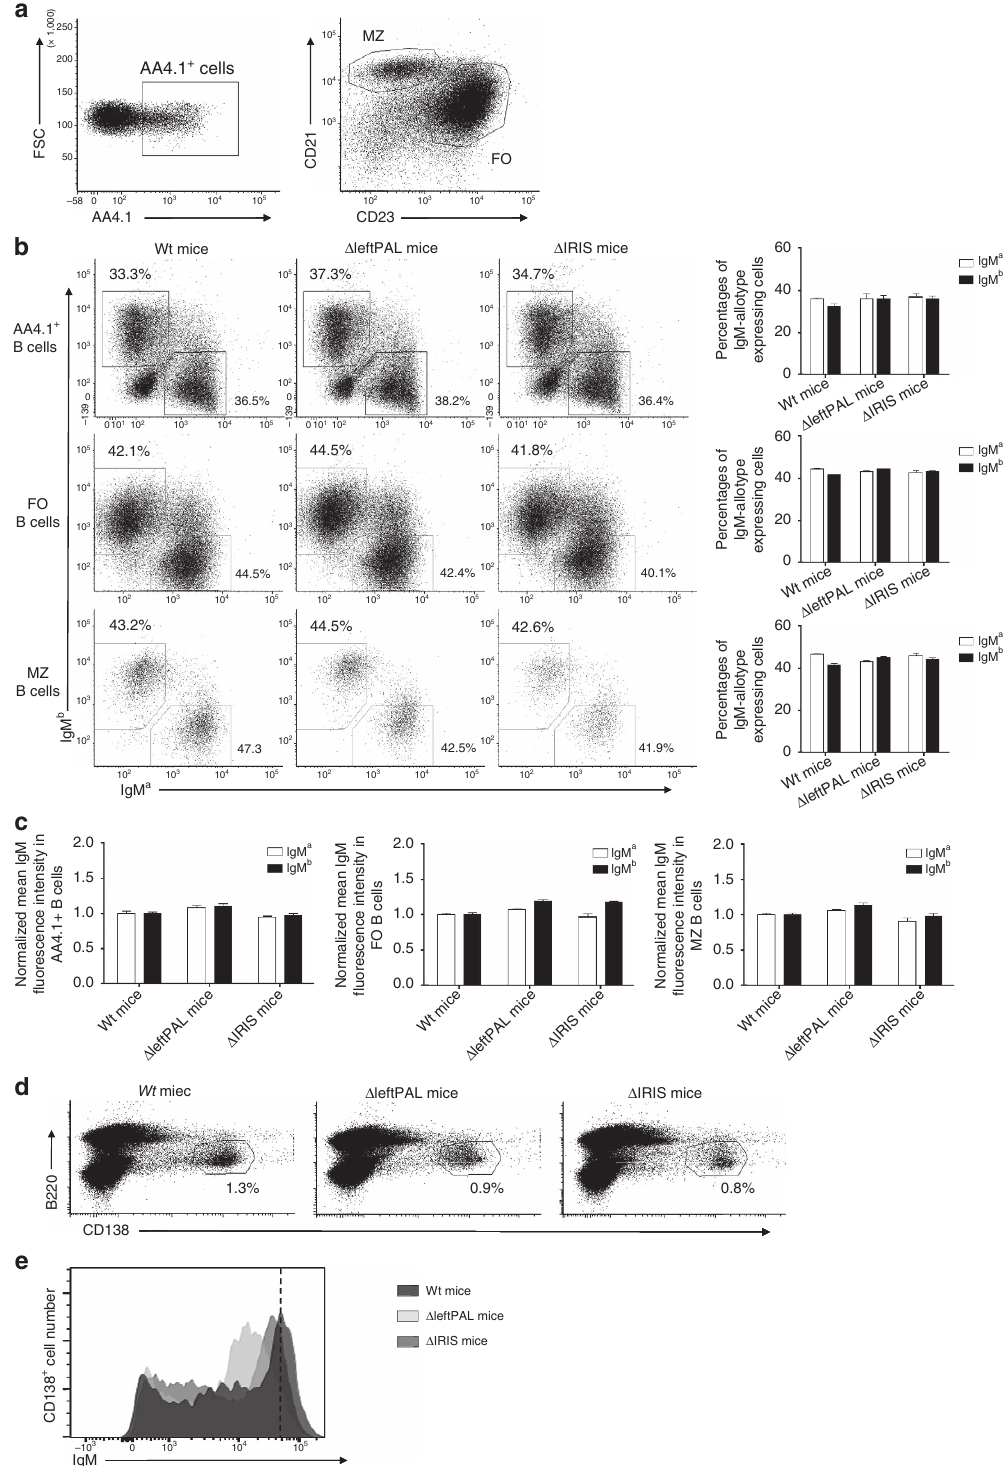
Figure 6 | Influence of the 3’RR palindrome on BCR expression and B-cell fate. ( a ) Flow cytometry analysis of transitional (TR) B cells (AA4.1 þ ), follicular (FO) B cells (CD21 low CD23 high ) and marginal zone (MZ) B cells (CD21 high CD23 low ). One representative experiment out of five is shown (8- to 12-week-old mice, male and female). ( b ) TR, FO and MZ B cells expressing the a or b allele in a D leftPAL /b wt , a D IRIS /b wt and a wt /b wt mice. One representative experiment out of five is shown (left part). Mean ± s.e.m. of five mice for all genotypes (right part; 8–12-week-old mice, male and female). ( c ) Mean ± s.e.m. of membrane IgM densities on TR, FO and MZ B cells expressing the a or b allele in a D leftPAL /b wt , a D IRIS /b wt and a wt /b wt mice (8–12-week-old mice, male and female). ( d ) Flow cytometry analysis of plasmablasts (B220 þ CD138 þ ) in spleen of homozygous a D leftPAL /b wt , a D IRIS /b wt and a wt /b wt mice. One representative experiment out of three is shown (8- to 12-week-old mice, male and female). ( e ) Expression of IgM on plasmablasts of homozygous D leftPAL, D IRIS and wt mice. One representative experiment out of three is shown (8- to 12-week-old mice, male and